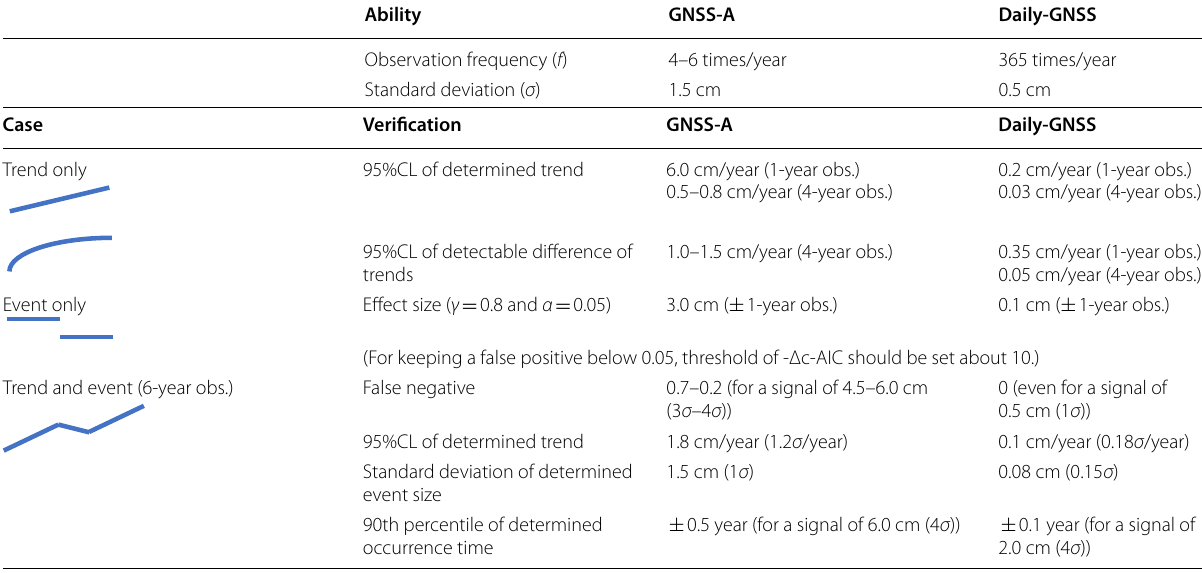
Table 2 Summary of the signal detection and determination capabilities of vessel‑GNSS‑A and daily‑GNSS in 2021